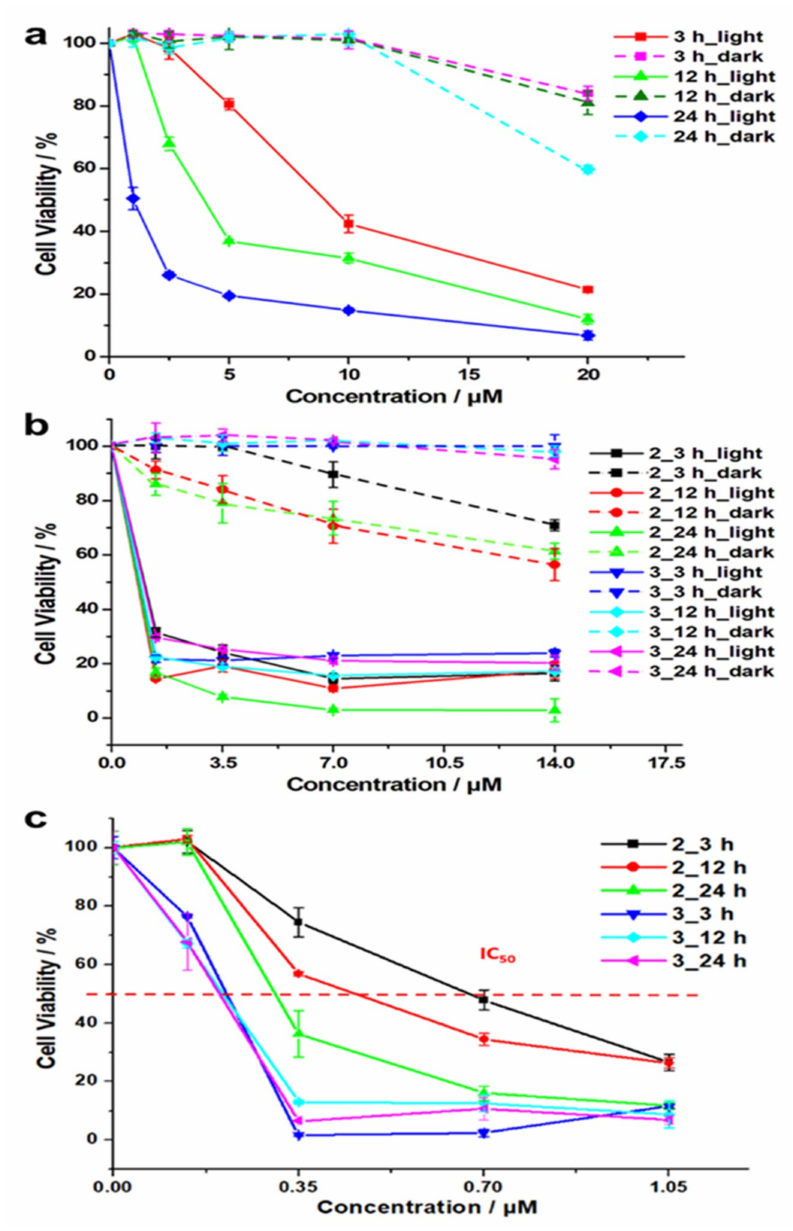
Figure 4. Cell viability against A549 cells for photocytotoxicity (light, total light dose 2 J · cm − 2 ; irradiation time 15 min) and dark cytotoxicity (dark) after 3, 12, and 24 h incubation times of ( a ) 1 at concentrations of 1.0–20.0 µ M, ( b ) 2 and 3 at concentrations of 1.4–14.0 µ M, and ( c ) photocytotoxicity (total light dose 2 J · cm − 2 ) of 2 and 3 at low concentrations of 0.14–1.05 µ M. The percentage of cell viability was determined by an 3-(4,5-dimethylthiazol-2-yl)-2,5-diphenyltetrazolium bromide (MTT) assay. Error bars represent the standard deviation of three replicate